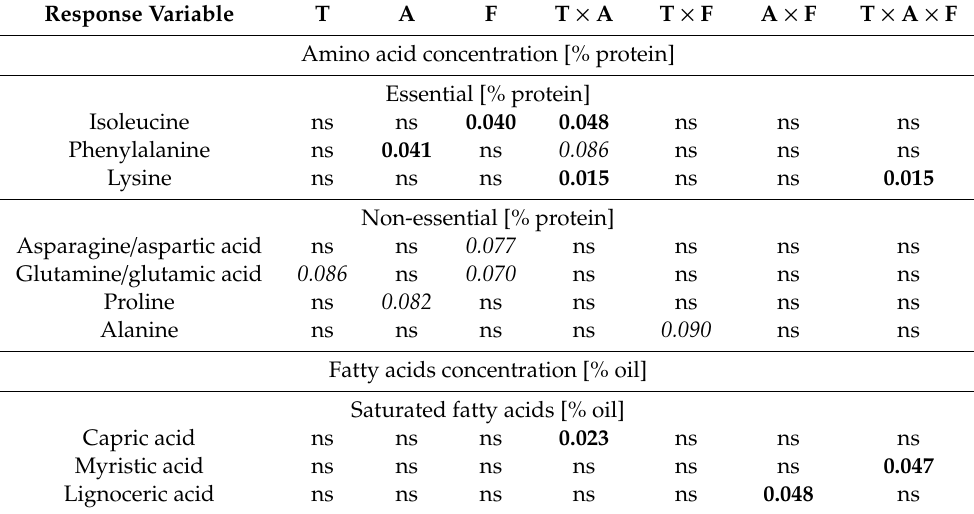
Table 3. Overall statistical analyses of impacts of soil warming (T), precipitation amount (A), precipitation frequency (F) as well as their interactions, on amino acid concentration (% protein) and fatty acid concentration (% oil) of mature OSR seeds. 1 Only parameters are presented that yielded significant e ff ects of, or interactions between, treatments.